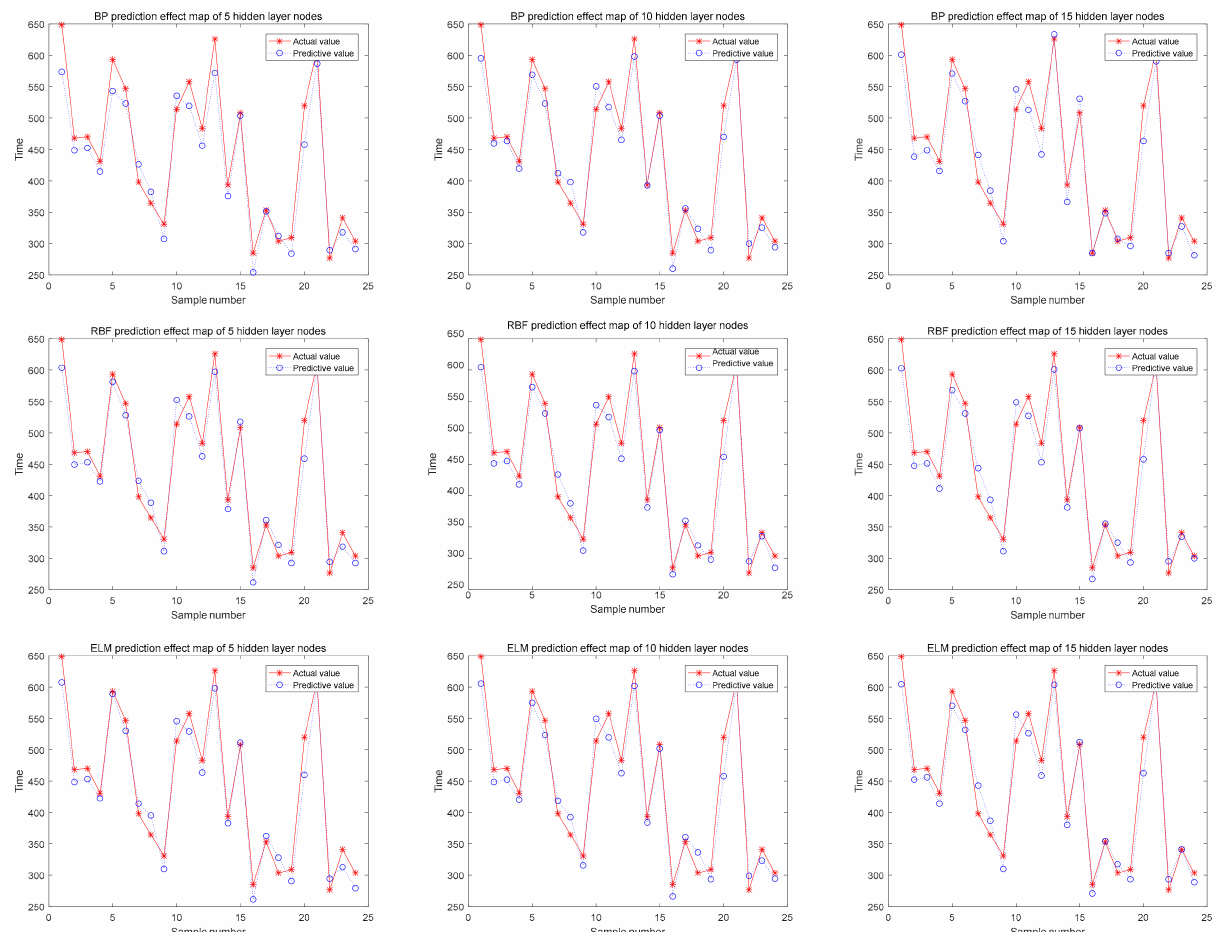
Figure 10. Prediction time comparison of different